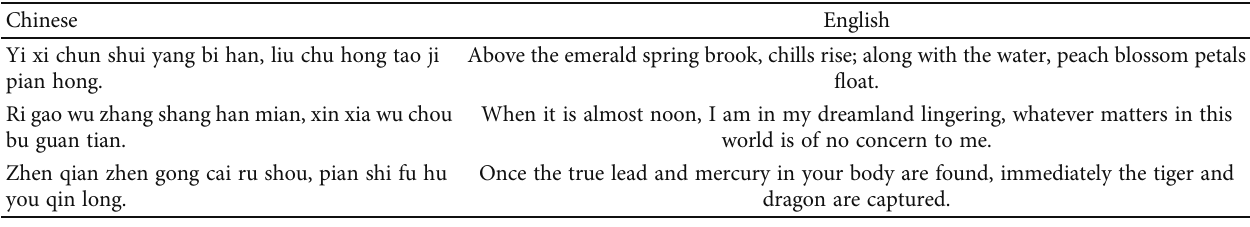
Table 1: Examples of Chinese and English sentences.